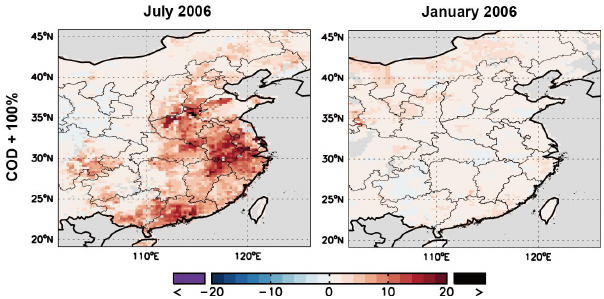
Fig. 5. Spatial distribution of percentage differences between mod- eled NO 2 columns with and without doubling the COD. See Fig. S10 for more results of sensitivity tests on